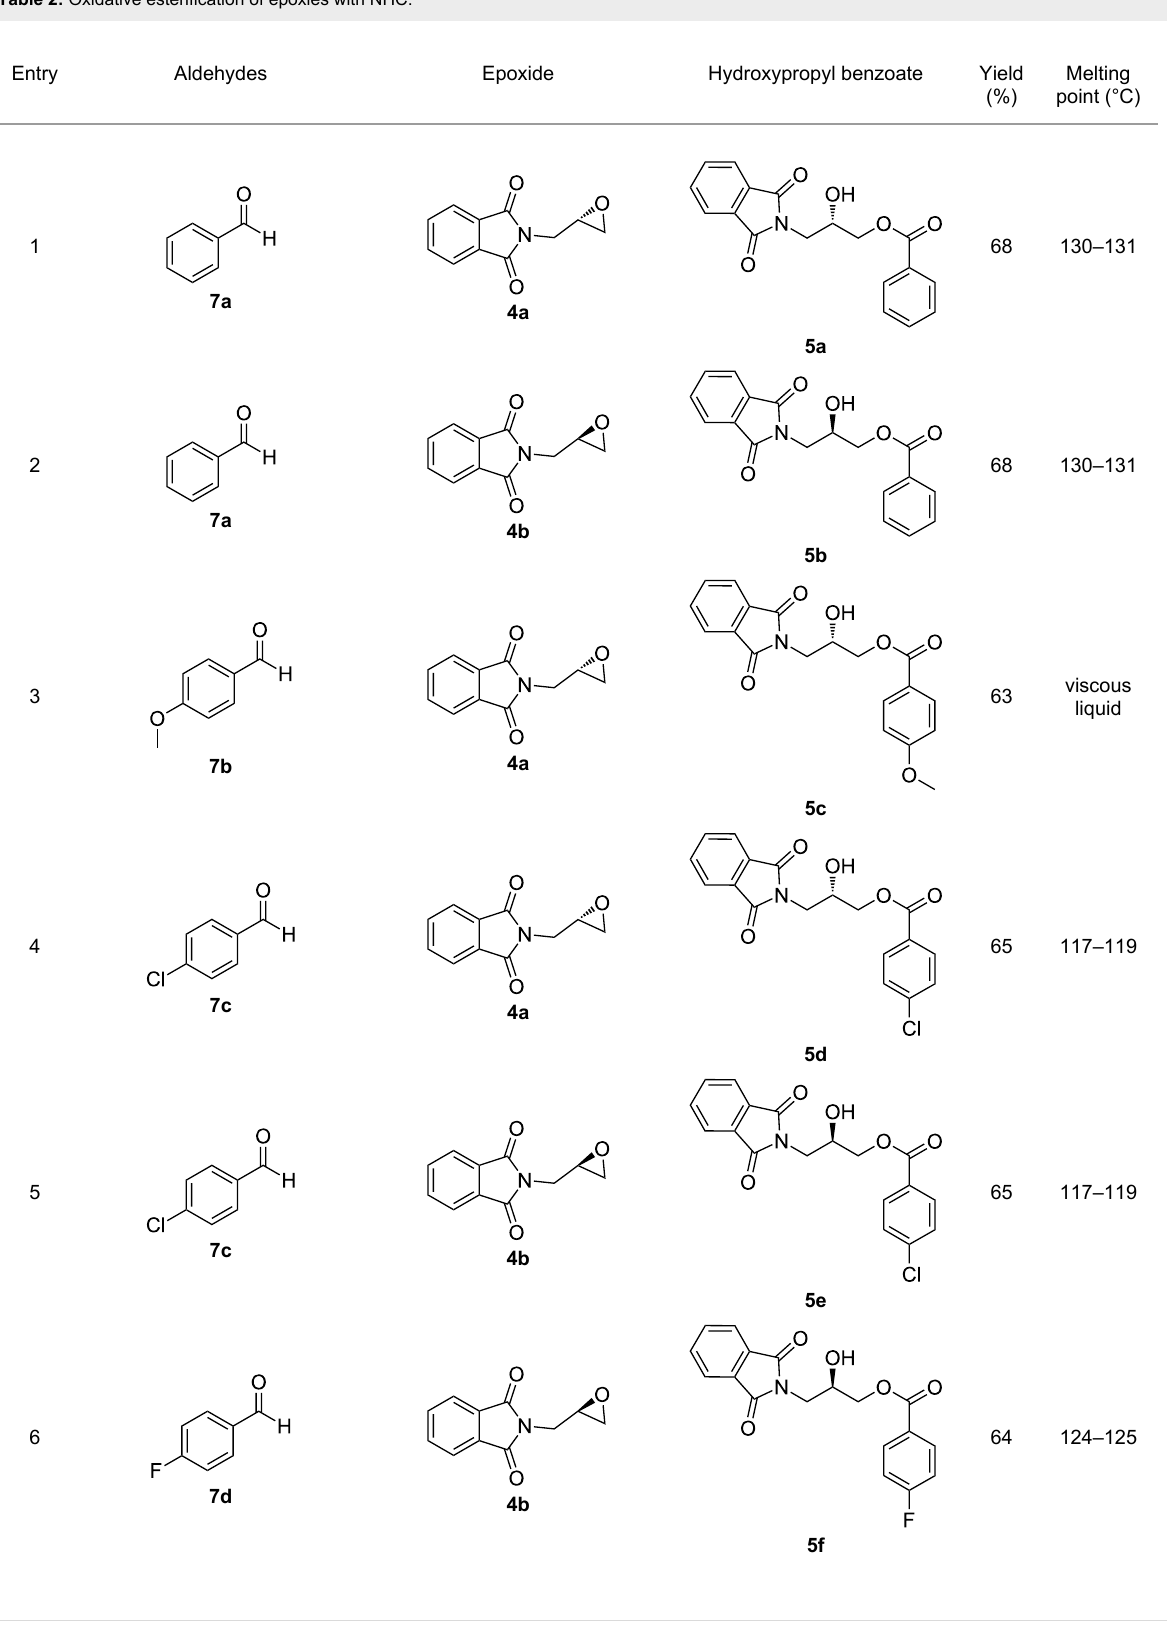
Table 2: Oxidative esterification of epoxies with NHC.